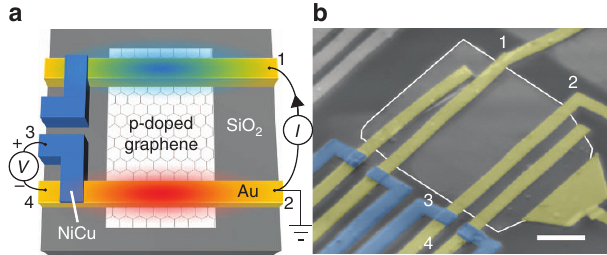
Figure 2 | Device architecture and measurement configuration. ( a ) Schematic of the measurement geometry. A graphene flake (white) on a Si/SiO 2 substrate is contacted with Au leads (yellow). NiCu leads (blue) form thermocouples to probe the temperature of the graphene–metal interface. We define the current as sent from contact 1 to 2 and probe the thermocouple at contacts 3 and 4. ( b ) Coloured electron micrograph of an actual device. Scale bar, 1 m m. The graphene flake is outlined in white for